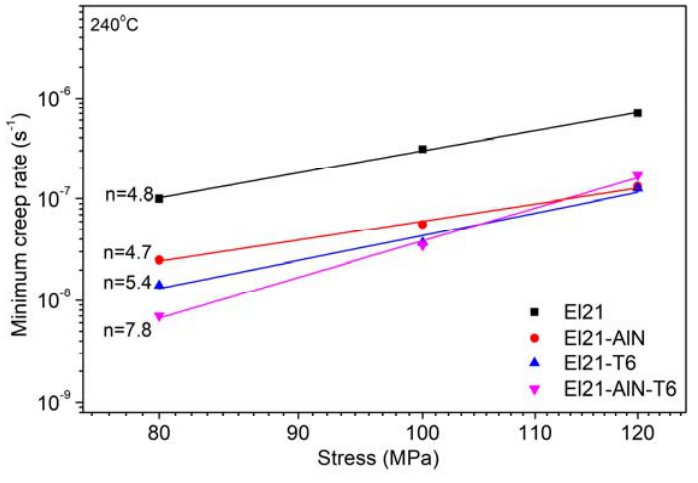
Figure 20. Double logarithmic plot of minimum creep rate as a function of applied stress.